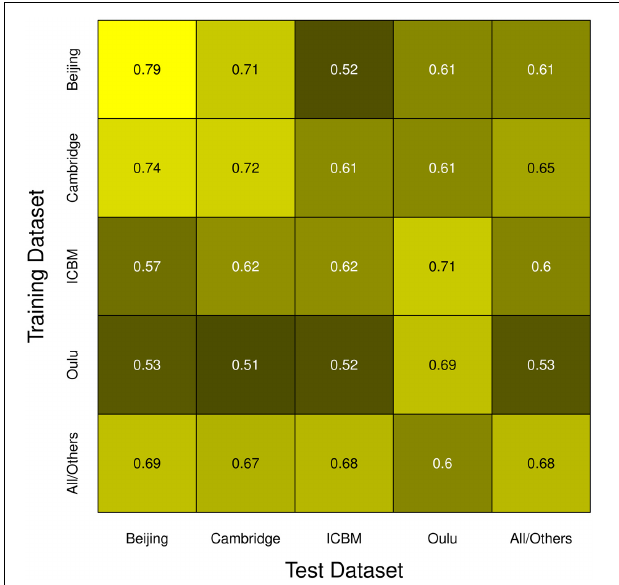
FIGURE 7 | Summary of all simulation runs. The color of each cell represents the mean accuracy of the respective test/training dataset pair’s simulation run with the largest of the sample sizes used in that comparison, with brighter colors corresponding to higher test accuracies. Note the highest accuracies being located in the main diagonal, as well as the asymmetry in the off-diagonal cells.